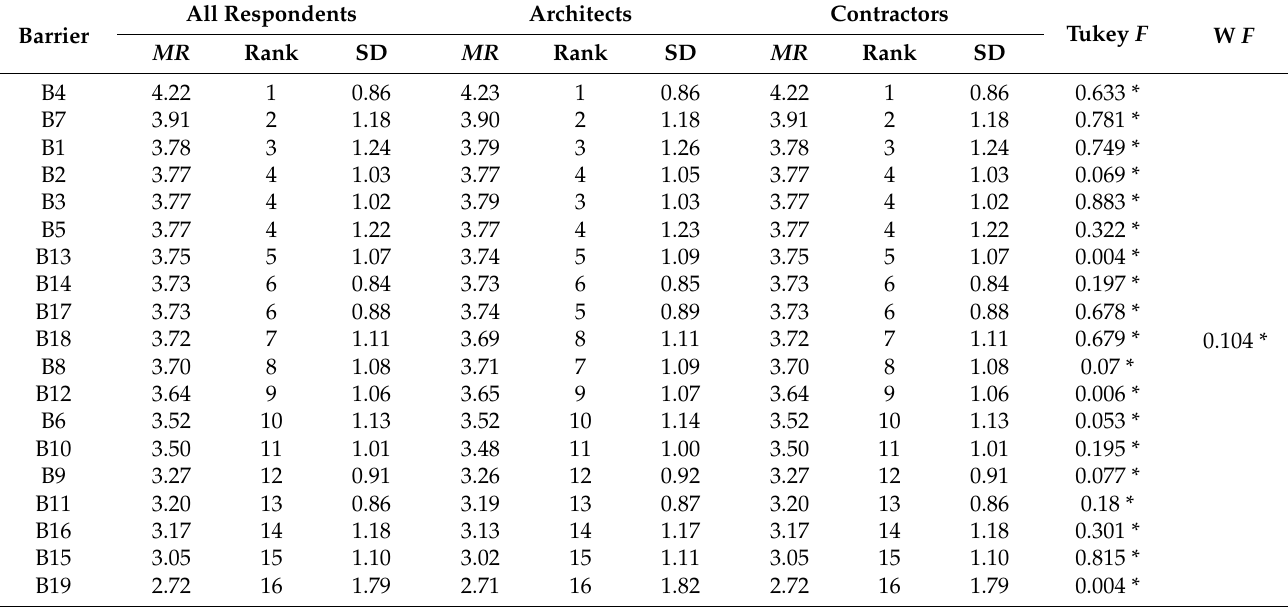
Table 4. Mean ratings, ranking, pairwise, and inter-group comparisons of the significance of the differences in ranks for key barriers to BIM